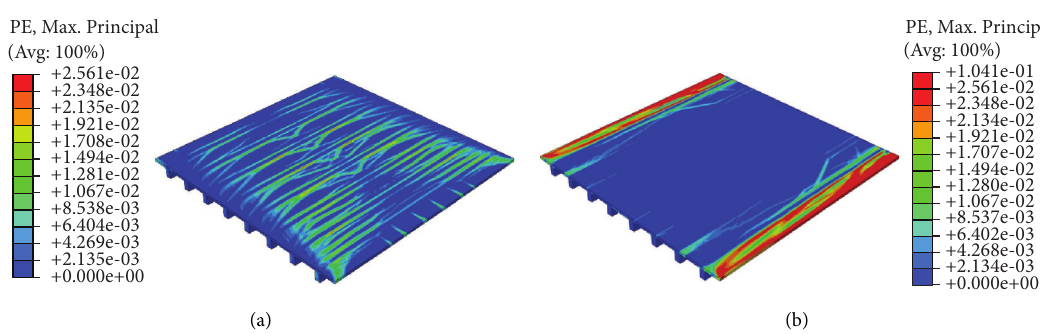
Figure 10: Distribution of main maximum plastic strain which is equivalent to cracking strain at concrete slab at 15mm displacement. (a) Distribution of tensile cracks in the model by loading in X direction. (b) Distribution of tensile cracks in the model by loading in Z direction. PE, Max. Principal